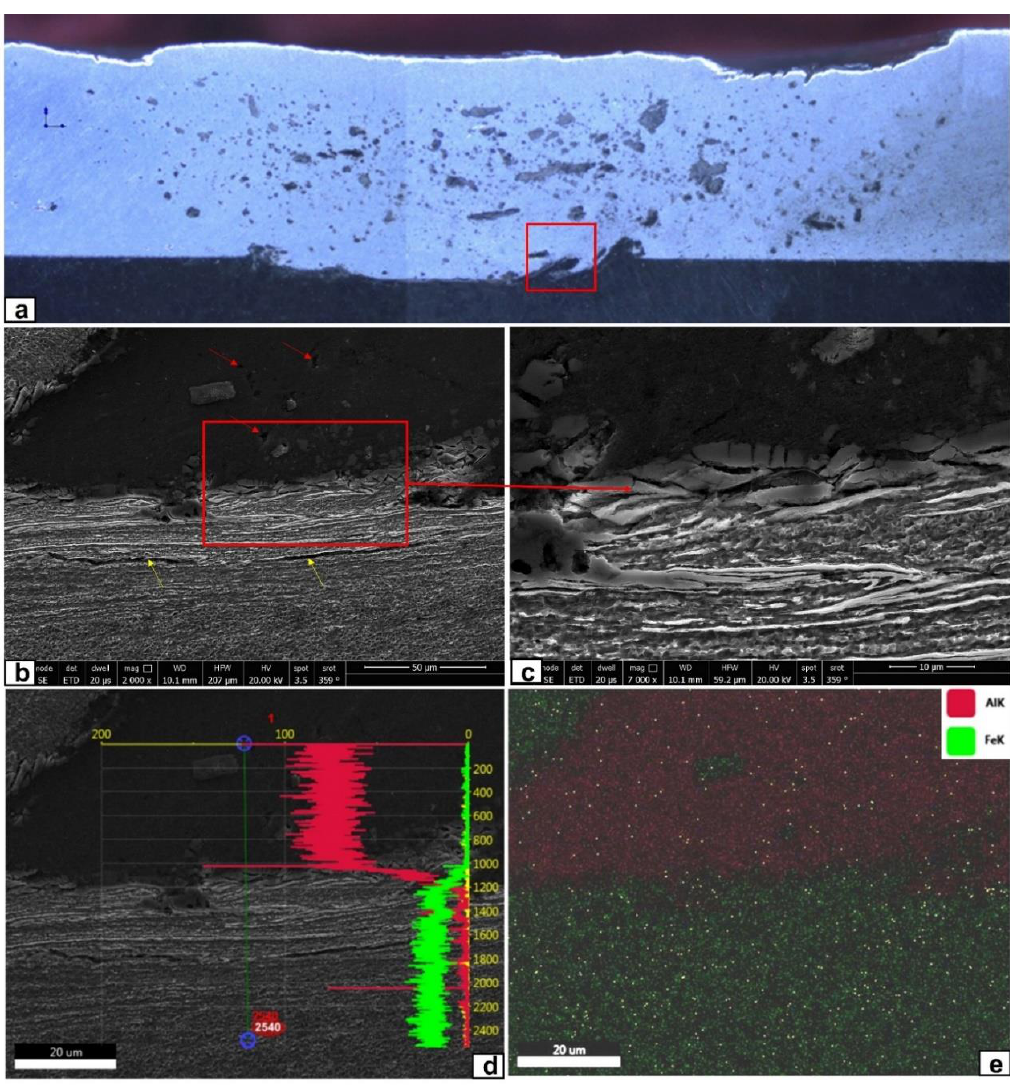
Figure 12. Optical macrograph ( a ), SEM Micrograph ( b , c ), and EDS mapping ( d , e ) of the aluminum/steel interface produced with high FSP rotation speed of 1500 rpm and pin length of 3.2 mm.